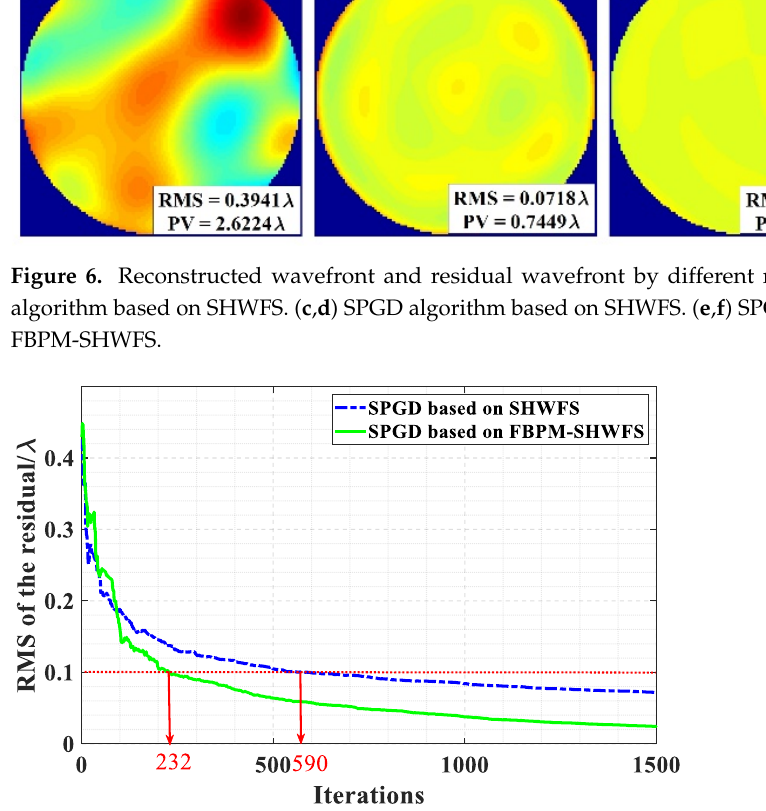
Figure 7. The evolution curves of the residual wavefront RMS with both structures.